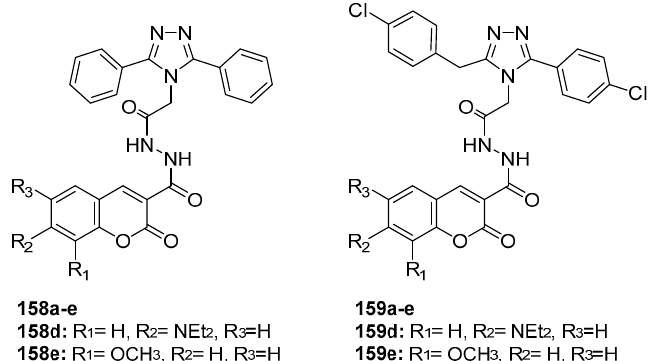
Figure 53. Coumarin derivative from Ainsliaea fragrans.